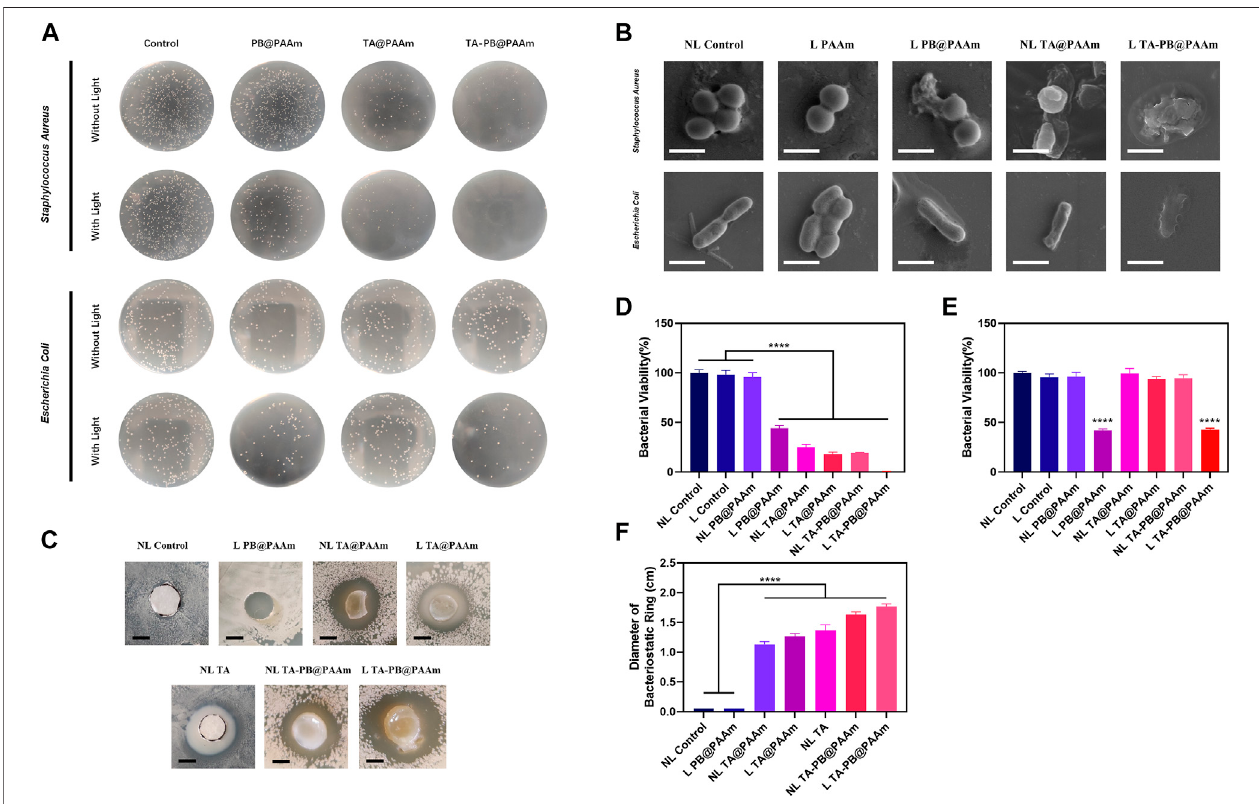
FIGURE 5 | In-vitro bactericidal test of composite photothermal hydrogel. (A) Bacteriostatic experiment of different hydrogels on Staphylococcus aureus and Escherichia coli . (B) The SEM result of the bacterial morphology through the treatment of different hydrogels on S. aureus and E. coli . Scale bar (cid:1) 1 μ m. (C) Bacterial inhibitionringtestresultsofdifferentmaterials.Scalebar (cid:1) 5 mm. (D) Quantitativeresultsofthesurvivalrateof S.aureus . (E) Quantitative resultsofsurvivalrateof E.coli . (F) Quantitative results of the diameters of bacterial inhibition ring tests. Data are mean ± SD (n (cid:1) 3, **** p <